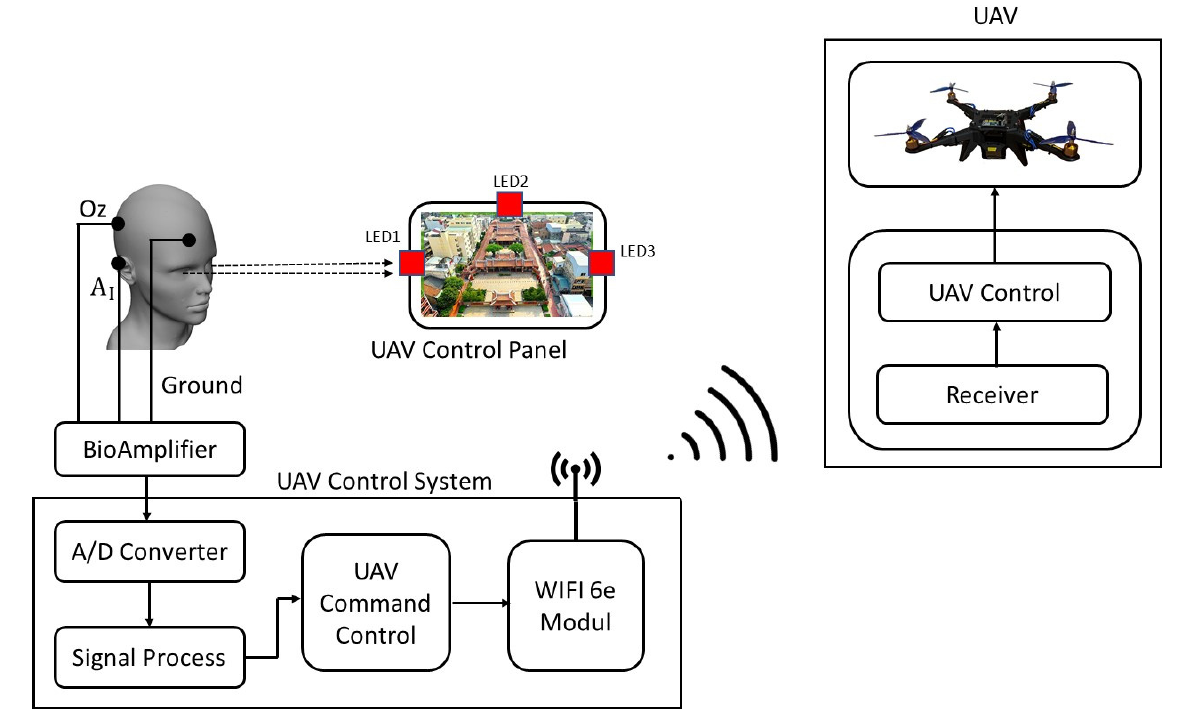
Figure 1. The schematic diagram of UAV with SSVEP–BCI system.